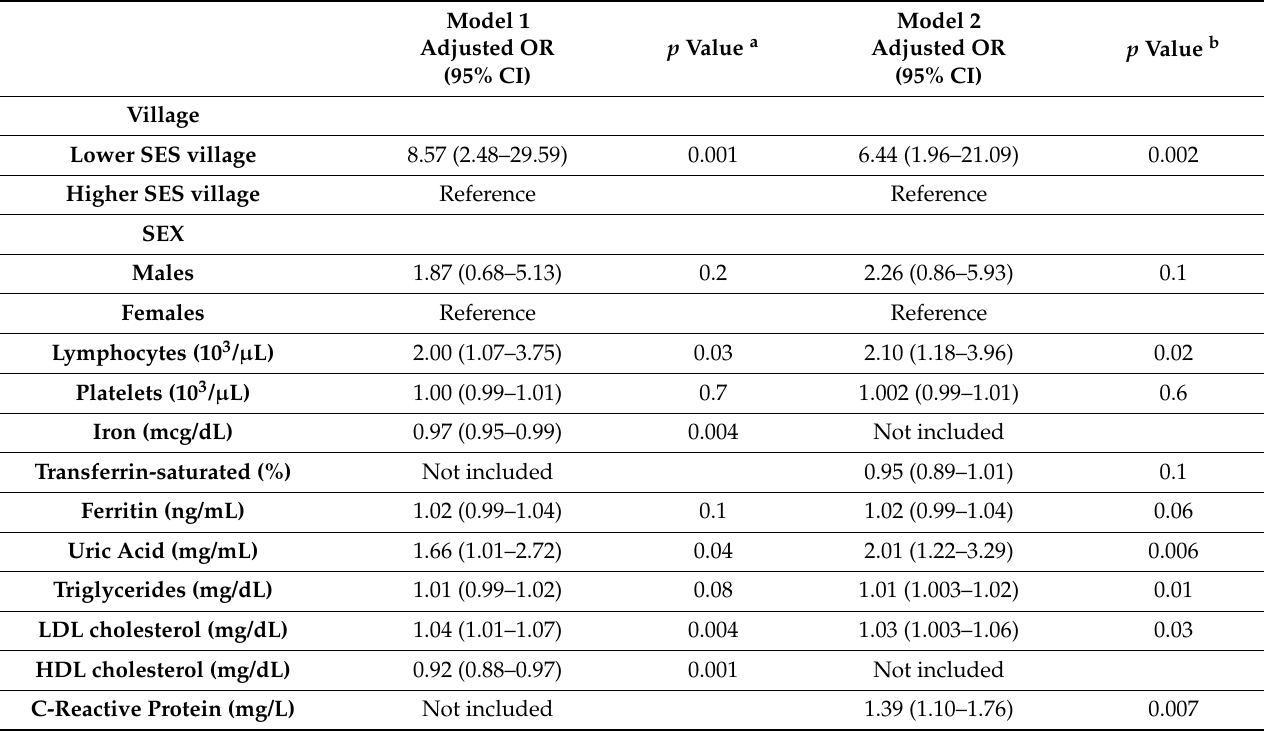
Table 4. Associations of nutritional and inflammation biomarkers with overweight/obesity among children aged 10–12